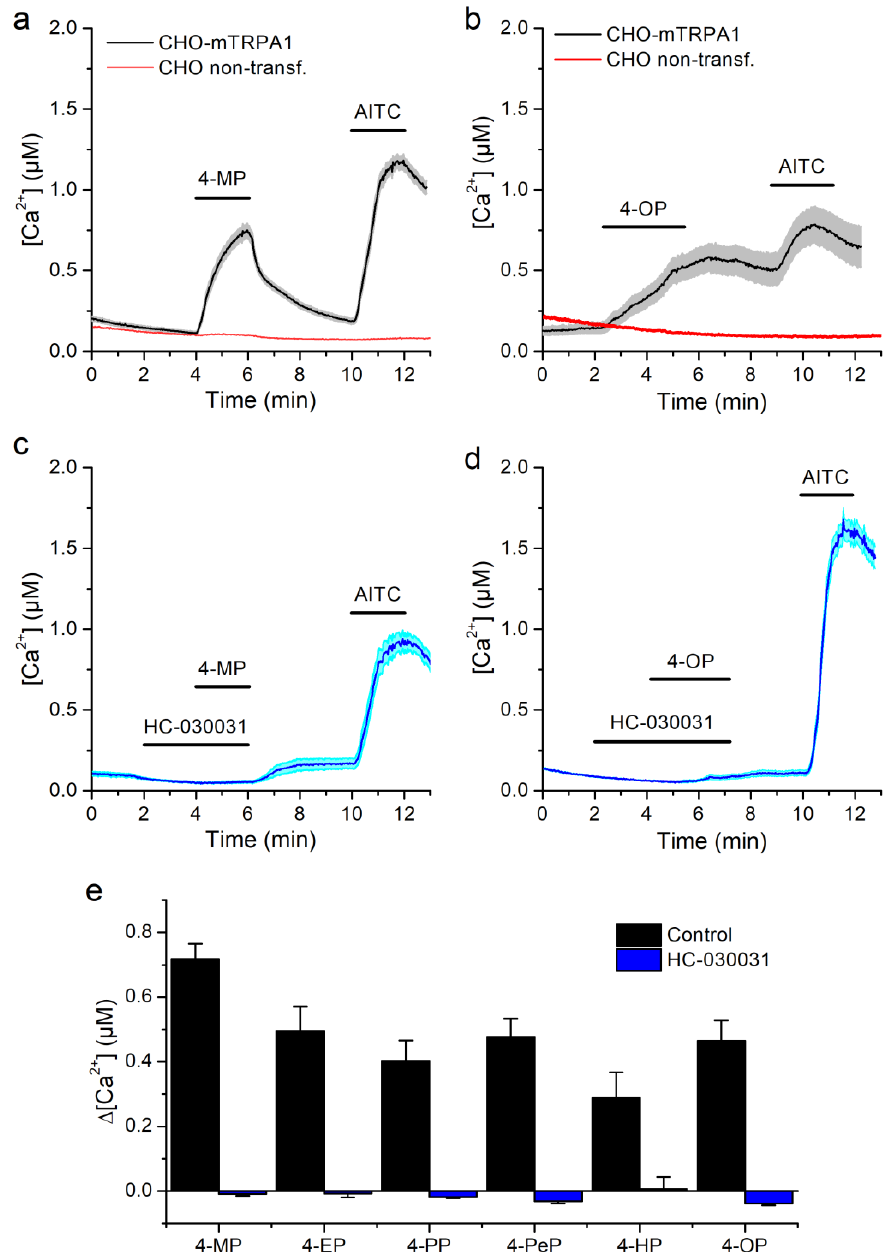
Figure 1. mTRPA1-mediated responses to alkylphenols. ( a , b ) Average traces of [Ca 2+ ] recorded in CHO-mTRPA1 or non-transfected CHO cells showing the effects of 4-methylphenol (4-MP, 1300 µ M, a ) and 4-octylphenol (4-OP, 3.8 µ M, b ). ( c , d ) Average traces of [Ca 2+ ] recorded in CHO-mTRPA1 cells showing the lack of effects of 4-methylphenol (4-MP, 1300 µ M, c ) and 4-octylphenol (4-OP, 3.8 µ M, d ) in the presence of TRPA1 inhibitor HC-030031 (50 µ M). ( e ) Average [Ca 2+ ] change induced by alkylphenols (APs) in the control condition and in the presence of HC-030031. APs were applied at concentrations of 1300, 110, 60, 38, 10, and 3.8 µ M for 4-MP, 4-EP, 4-PP, 4-PeP, 4-HP, and 4-OP respectively. The data is represented as mean ± s.e.m. ( n >